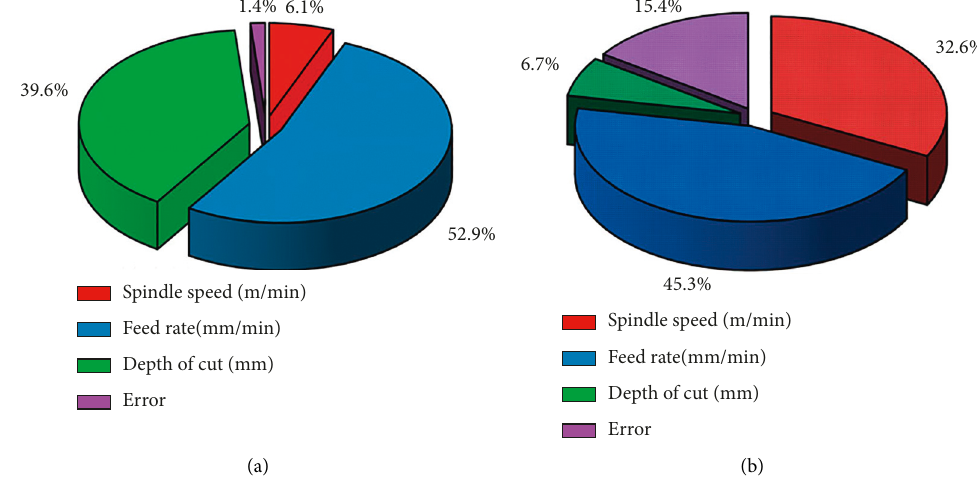
Figure 7: Percentage contribution chart, (a) material removal rate, and (b) surface